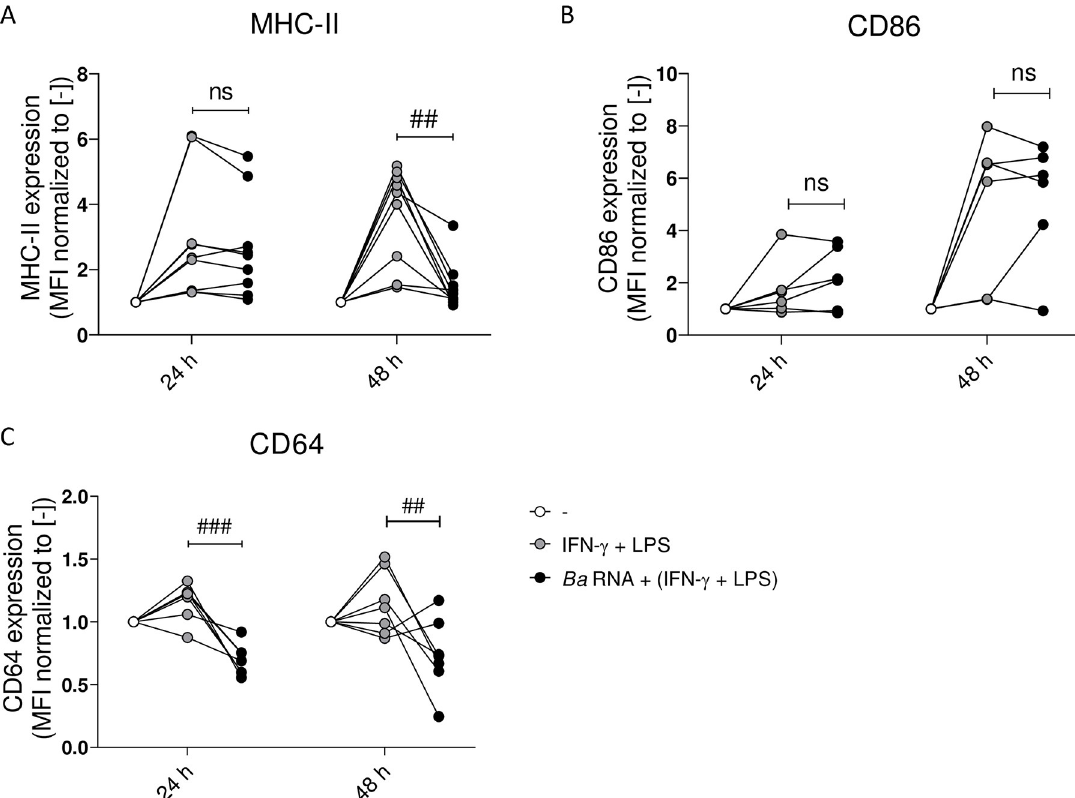
Fig 5. Ba RNA interferes with the expression of M1 markers at 48 h. Human M0 macrophages were stimulated with Ba RNA for 24 and 48 h in the presence of IFN- γ + LPS. (A) MHC-II, (B) CD86 and (C) CD64 (M1 markers) expressions were determined by flow cytometry. Cells treated with IFN- γ and LPS were used as a positive control. Dots indicate the geometric means normalized to untreated cells of at least six independent experiments. MFI, mean fluorescence intensity. ns, non-significant; ## P < 0.01; ### P < 0.001 vs. cells treated with IFN- γ +